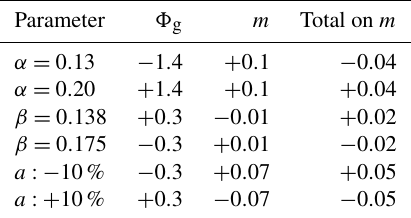
Table 2. Sensitivity of the GF (assessed from inverse runs, mWm − 2 ) and basal melt rate (calculated with forward runs, mma − 1 ) to input parameters α , β and a . As the final value of m depends on both the inverse run to determine (cid:56) g and the forward run to compute the melt rate, the last column accounts for the sen- sitivity on the whole procedure (inverse +